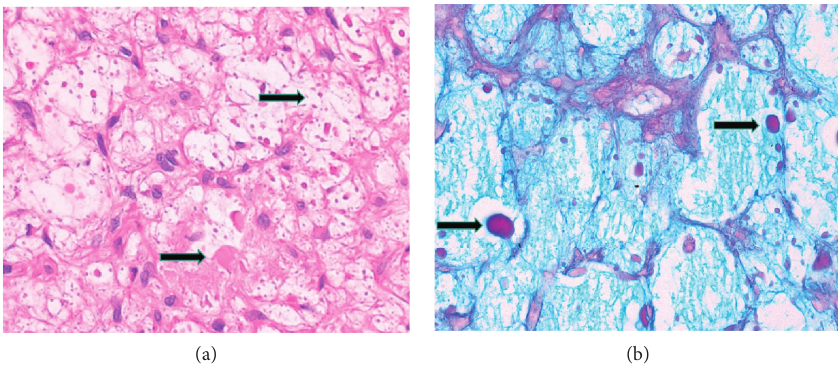
Figure 2: × 400 hematoxylin and eosin stained section (a) and Alcian blue special stain (b). Eosinophilic material of uncertain aetiology is present in some cells.